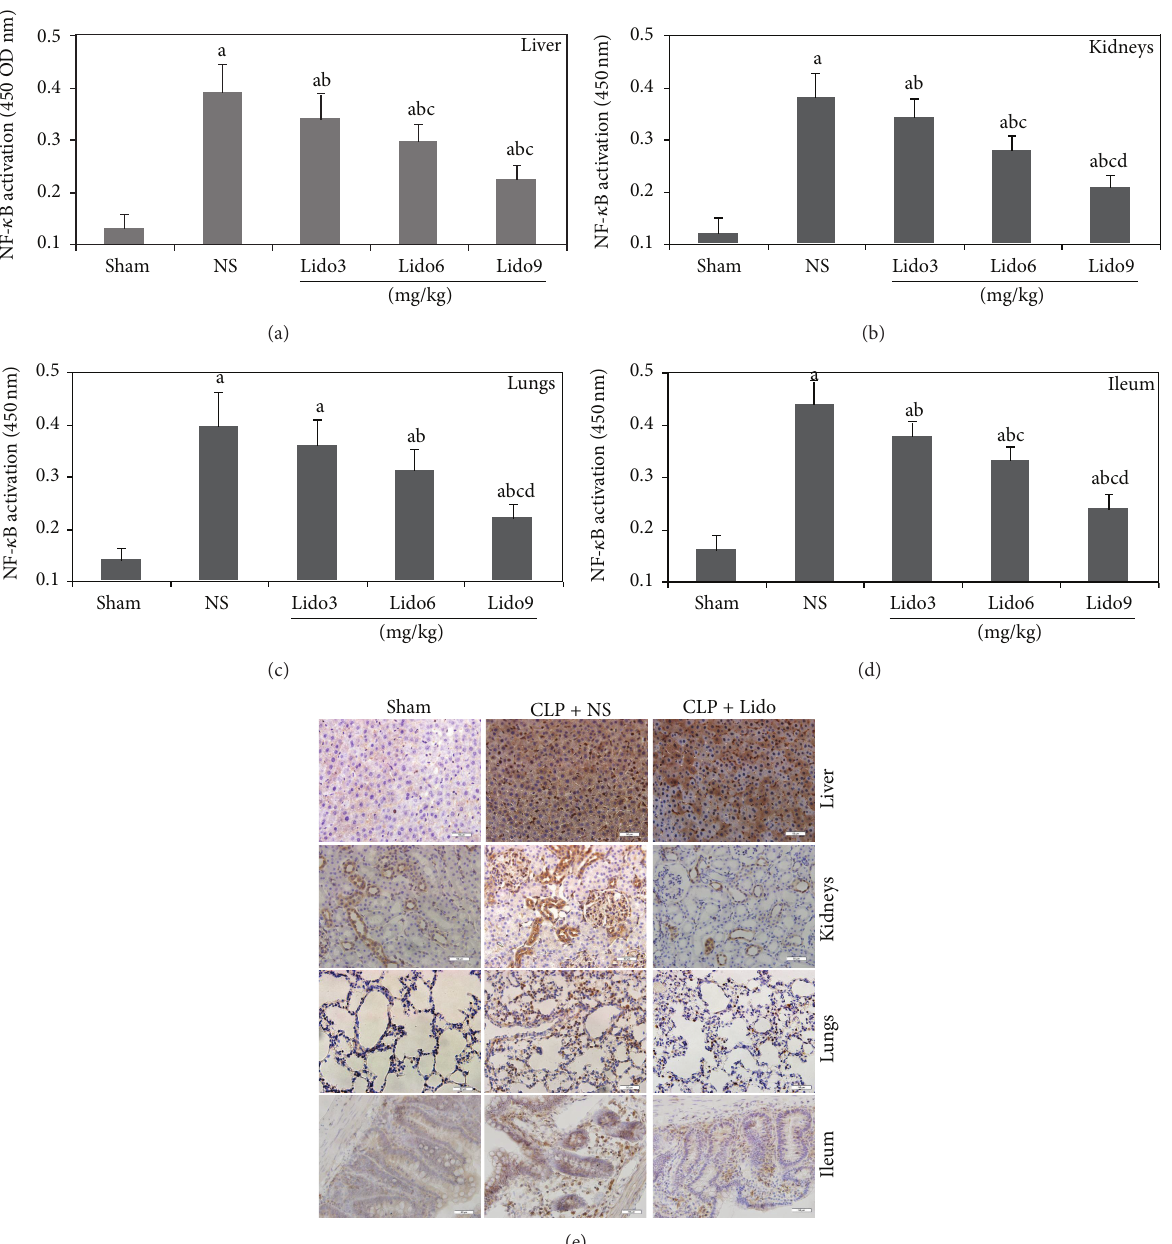
Figure 5: Lidocaine treatment inhibits translocation and activity of NF- 𝜅 B in organs of CLP-induced septic rats. Rats were treated with NS or lidocaine 10h after CLP. Liver, kidneys, lungs, and ileum were collected 24 h after CLP (a, b, c, and d). The nuclear fraction was collected and NF- 𝜅 B levels in the nuclear fraction were measured using the Active Motif NF- 𝜅 B family kit. Data are presented as mean ± SD ( 𝑛 = 5 ). a 𝑃 < 0.001 versus Sham; b 𝑃 < 0.001 versus NS; c 𝑃 < 0.001 versus Lido3 mg/kg; d 𝑃 < 0.001 versus Lido6mg/kg. (e) Immunohistochemical staining of nuclear factor- 𝜅 B p65 in liver, kidneys, lungs, and ileum from rats subjected to Sham and to CLP treated with NS and rats subjected to CLP treated with lidocaine 9 mg/kg at 24 h after CLP. Original magnification: × 400; NS: normal saline; Lido: